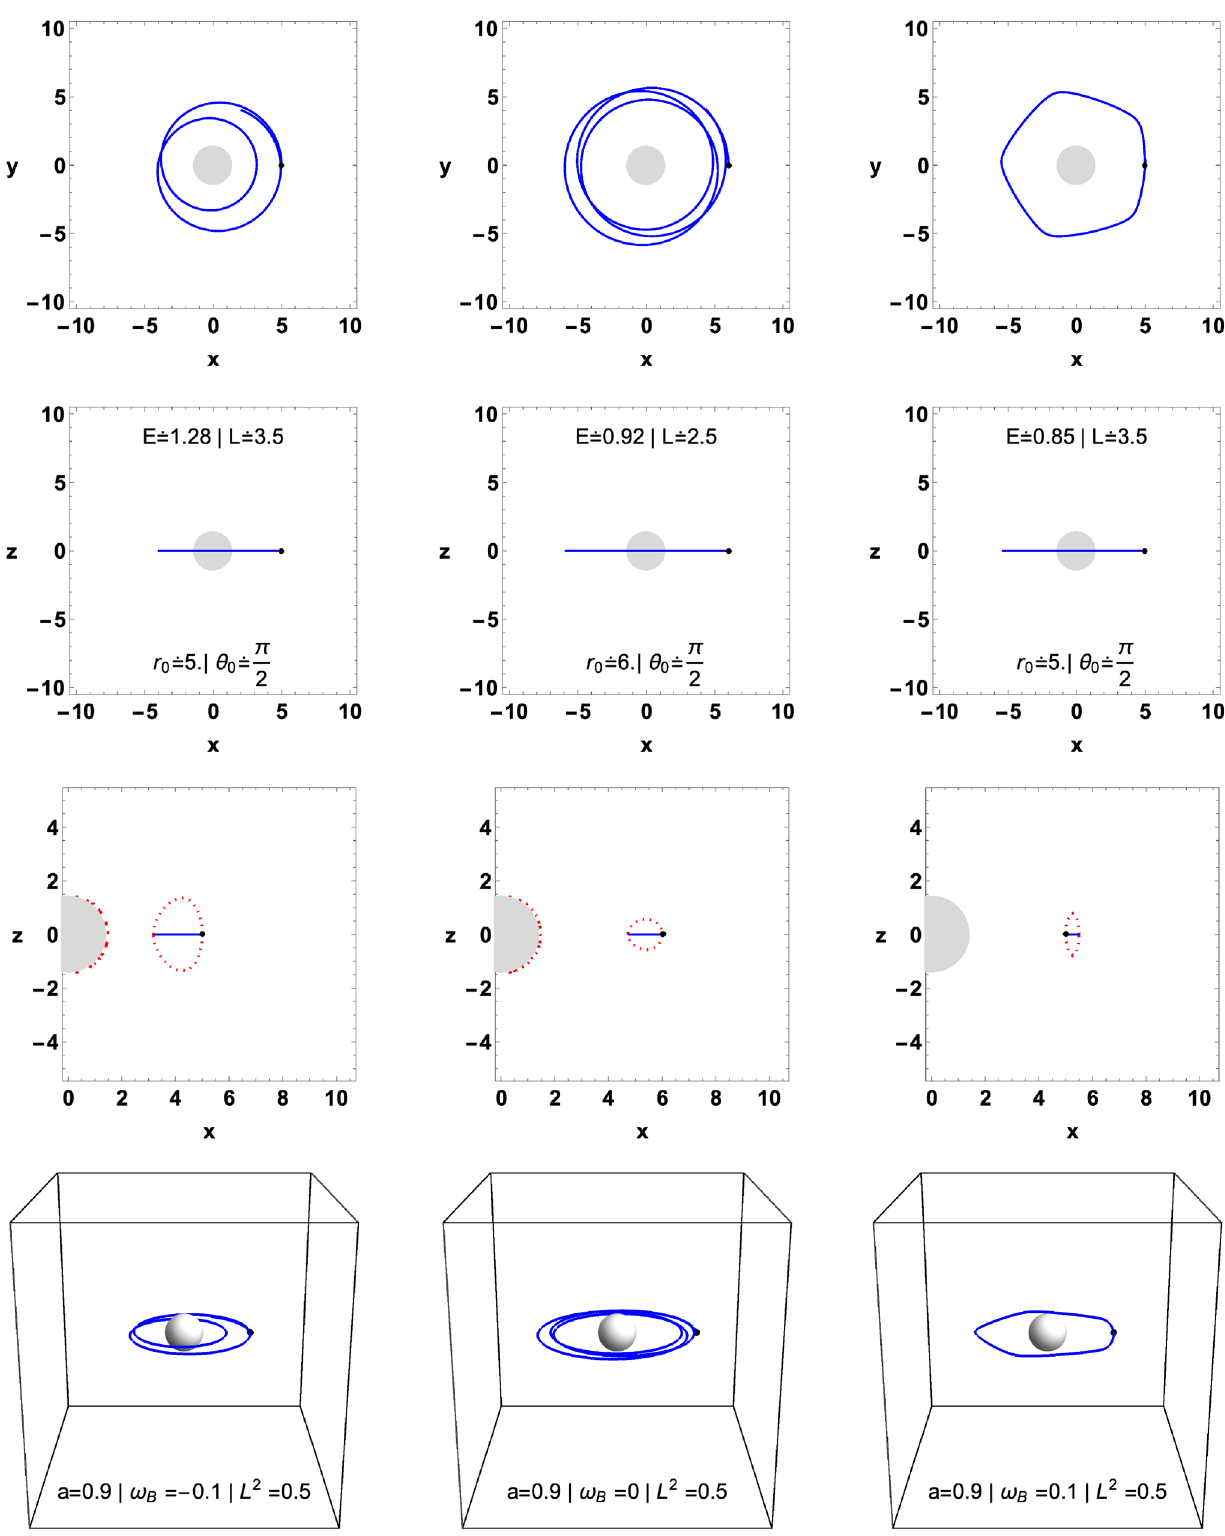
Fig. 15 Trajectories of charged particles on the equatorial plane θ 0 = π/ 2 for given values of rotation, magnetic and conformal parameters (the values of the parameters are the same for each column and written in the last row). Units in which M =